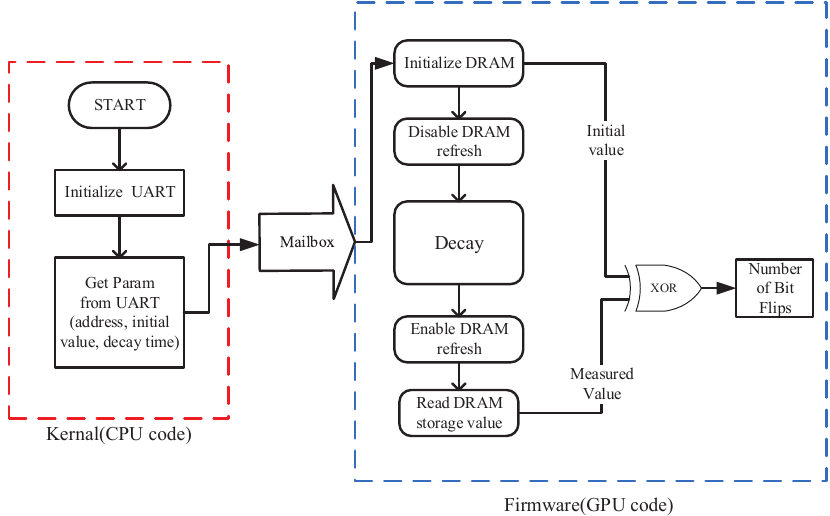
Figure 4. Structure of DRAM PUF implementation on Raspberry Pi (Rpi)